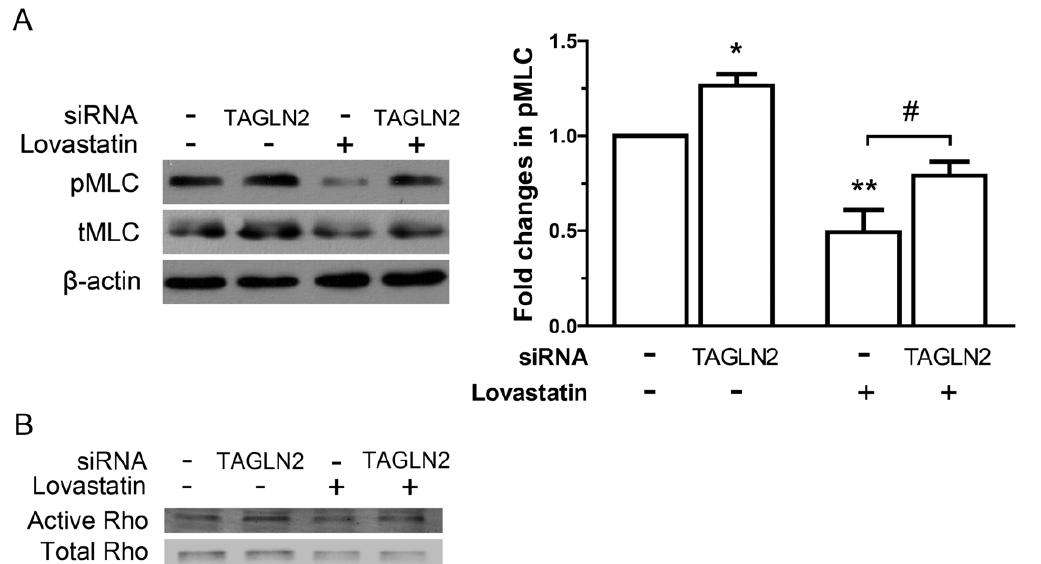
Figure 5. Transgelin 2 regulates HUVECs pMLC levels and Rho GTPases activation. HUVECs were transfected with transgelin 2 siRNA or a scrambled control, and followed by lovastatin (10 m M) treatment as described in Figure 4. (A) Western blot analysis of pMLC and tMLC in HUVECs. b - actin is employed as loading control. pMLC levels were quantitated by densitometry and normalized against b -actin (n=3). Each data point represents mean 6 SEM. p , 0.05; **, p , 0.01 versus control siRNA-transfected untreated cells; # , p , 0.05. (B) Cell lysates were immunoprecipitated with GST-RBD conjugated beads, and active Rho GTPase was detected by immunoblotting. Total cell lysates were subjected to immunoblotting to determine the expression level of total Rho. Experiments were repeated at least three